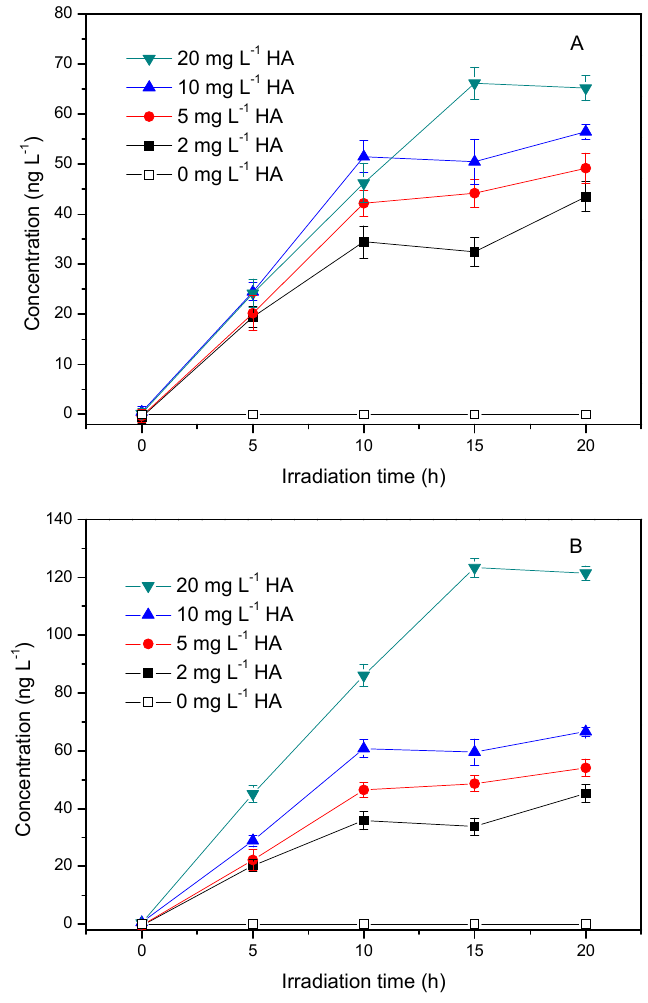
Figure 2. ( A ) E ff ect of HA concentration on the production of methyl chloride and ( B ) after corrected Figure 2. ( A ) Effect of HA concentration on the production of methyl chloride and ( B ) after for light shielding e ff ect using Equations (1)–(3). Reaction conditions: light intensity = 12 mW cm − 2 . corrected for light shielding effect using Equations (1)–(3). Reaction conditions: light intensity = 12 [Cl − ] = 0.5 mol L − 1 , pH = mW cm − 2 . [Cl − ] = 0.5 mol L − 1 , pH = 6.5.